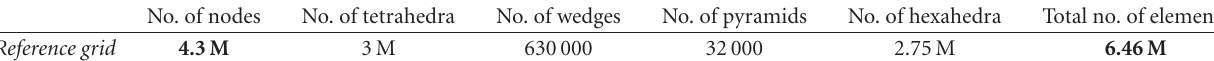
Figure 4: Reference grid. Table 1: Size of reference grid ( M = 10 6